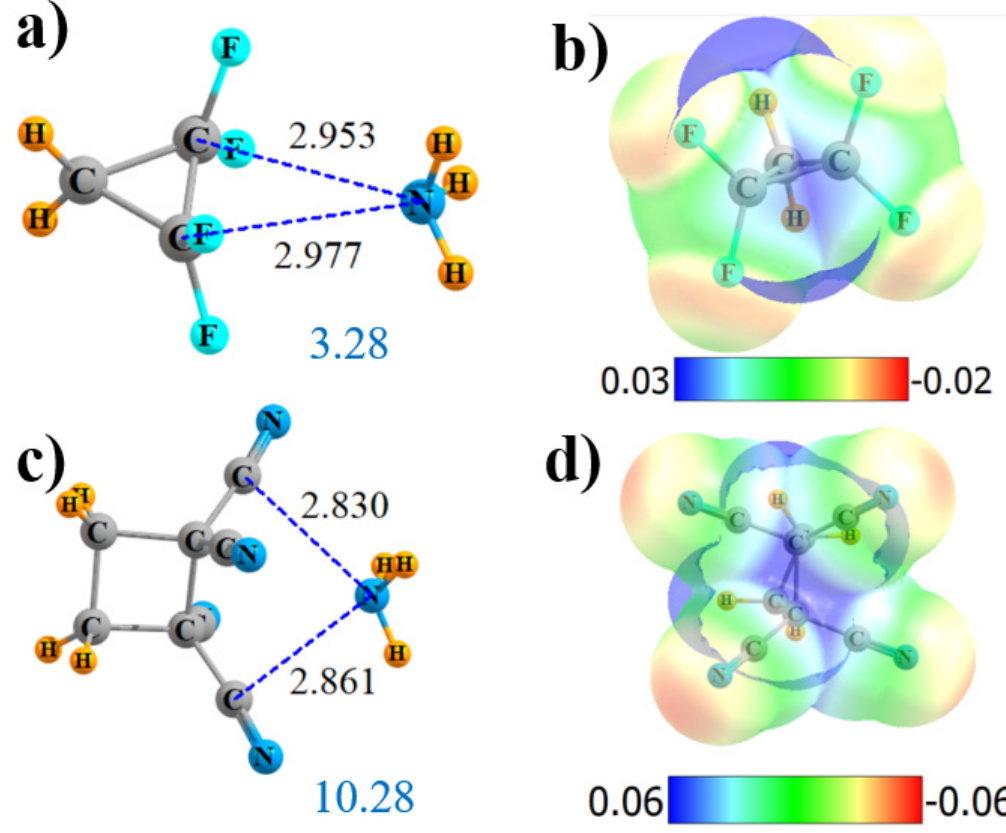
Figure 6. Geometries and monomer MEP of the complex of NH 3 with cyclic Lewis acids CH 2 {CF 2 } 2 ( a , b ) and CH 2 CH 2 {C(CN) 2 } 2 ( c , d ).